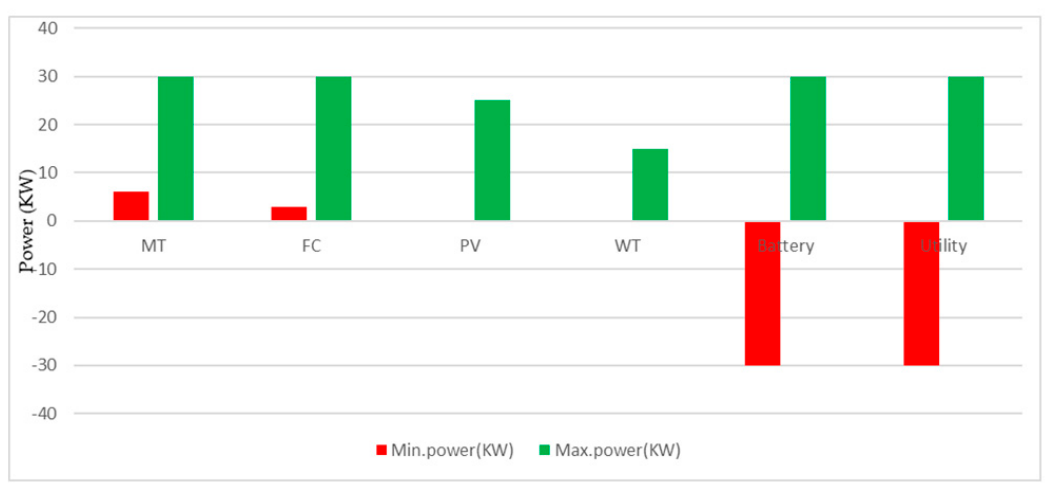
Figure 8. The power limits of the installed DG units .